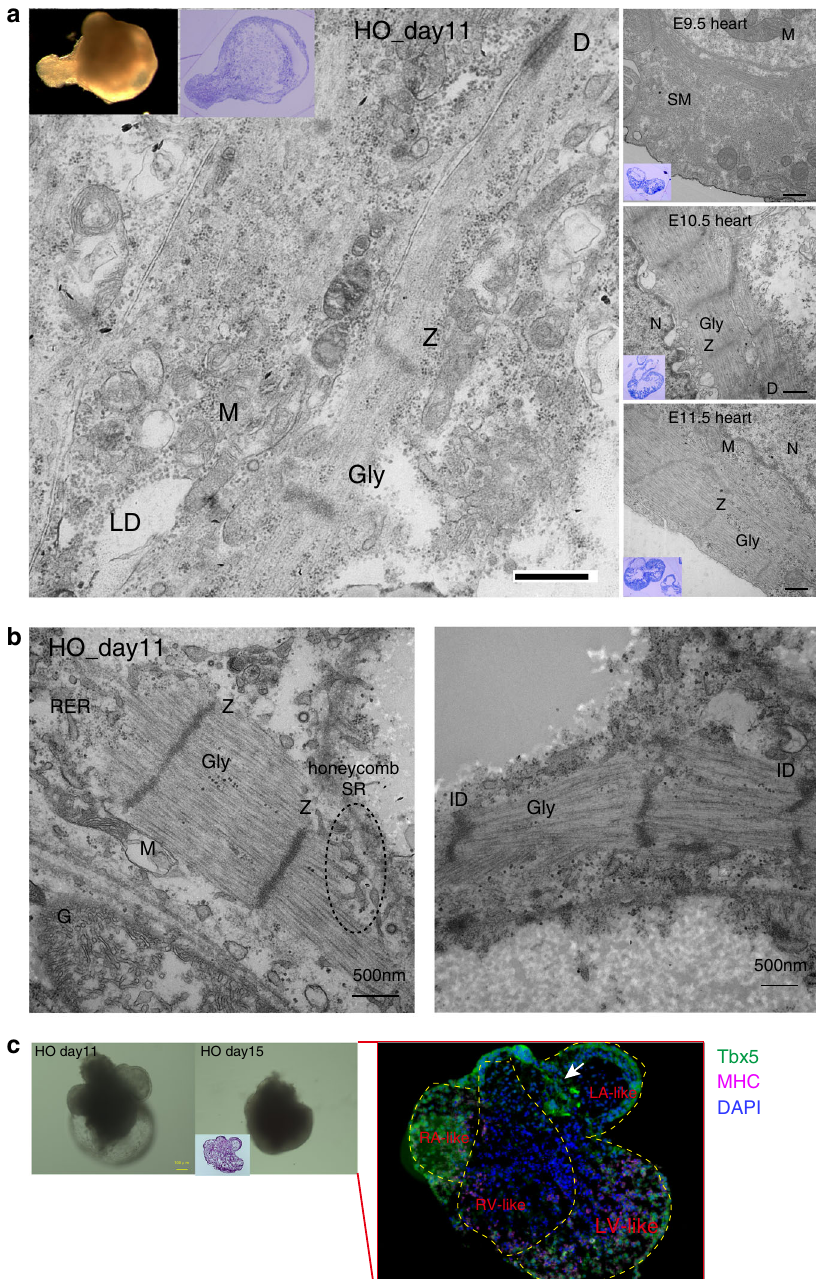
Fig. 2 General features of heart organoid (HO)s. a Ultrastructural analysis of the HO (insets, left: whole HO, right: a section stained with toluidine blue). Transmission electron microscopy of CM-like ultrastructures containing myo fi brils with Z-bands (Z), mitochondria (M), glycogen granules (Gly) in myo fi brils, lipid droplet (LD) and desmosomes (D). Scale bar: 400 nm. N nucleus, SM smooth muscle. Over n = 5, over three experiments. b Transmission electron microscopy of honeycomb sarcoplasmic reticulum (SR) structure (left) and wavy intercalated disc (ID; right) in ultrathin sections of CMs in the HOs. RER ribosomal endoplasmic reticulum, G Golgi complex. Scale bar: 500 nm; over n = 4, over three experiments. c Immunostaining to detect Tbx5 (green) and MHC (pink) (over n = 7, two experiments). The HO at day 11 and at day 15 (left panel, bright fi eld, scale bar: 100 μ m). Inset indicates hematoxylin and eosin-staining. Tbx5 expression (green) was positive in the left atrium (LA)-, right atrium (RA)- and left ventricle (LV)-like parts, MHC expression (pink) was strongly expressed in both LV- and RV-like parts, and a Tbx5-positive atria/ventricle (A/V) cushion-like structure was also detected (arrow). DAPI (blue) for nuclear To con fi rm whether the heart organoids (Fig. 2c, left) expressed Tbx5 expression in the heart organoids resembled that of in vivo cardiac transcription factors (TFs) and/or structural genes expressed embryonic hearts (E12.5H and E13.5H) after chamber formation by the in vivo embryonic heart, we assessed the expression of T-box (i.e., positive in the left atrium-, right atrium- and left ventricle-like transcriptional factor 5 (Tbx5, an important marker for proper parts) and also detected SM-MHC expression (Fig. 2c, right). development of both atria and the LV 27 – 31 ) and SM-myosin heavy Taken together, these results suggested that FGF4 and the chain (SM-MHC, an SM marker). Notably, the spatial pattern of gelated LN/ET complex are required for effective in vitro